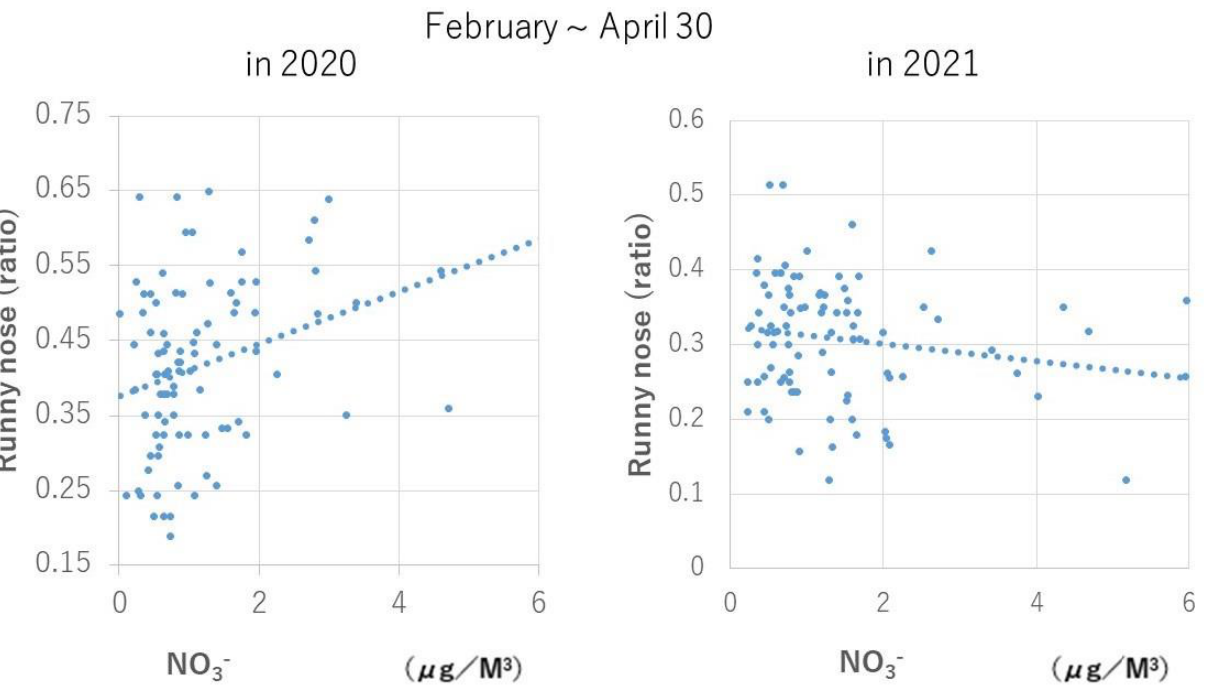
Figure 3. Relationship between daily Mg 2+ concentration and daily average of the ratio of peak ex- piratory flow rate to personal best peak expiratory flow rate on that day.